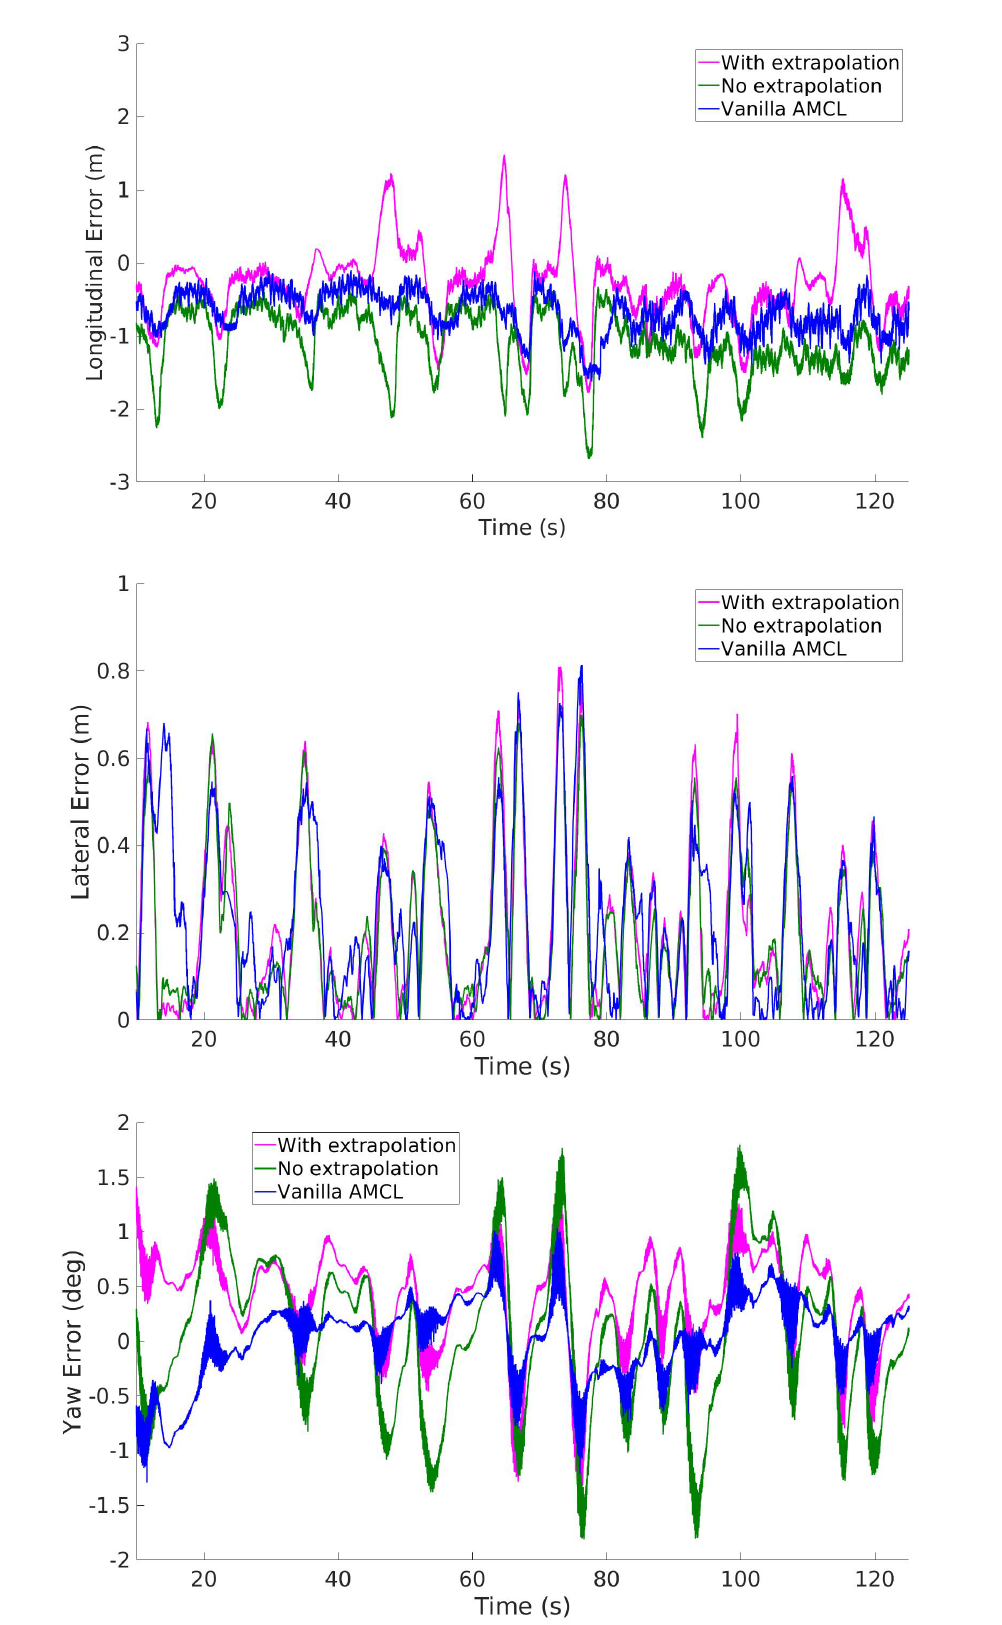
Figure 12. Comparison of the longitudinal, lateral and heading errors of two variants of IAMCL (with and without the extrapolation defined in Equation (7)) and the Adaptive Monte Carlo Localization (AMCL) algorithm during the second lap of the